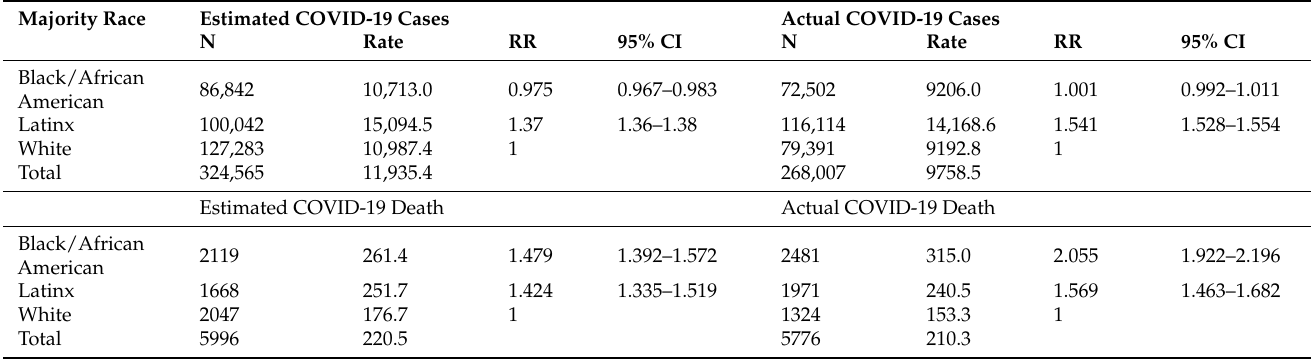
Table 2. The comparison between majority-race based estimation and actual number and rates for cumulative COVID-19 cases and deaths in Chicago between 1 March 2020, and 31 October 2021.